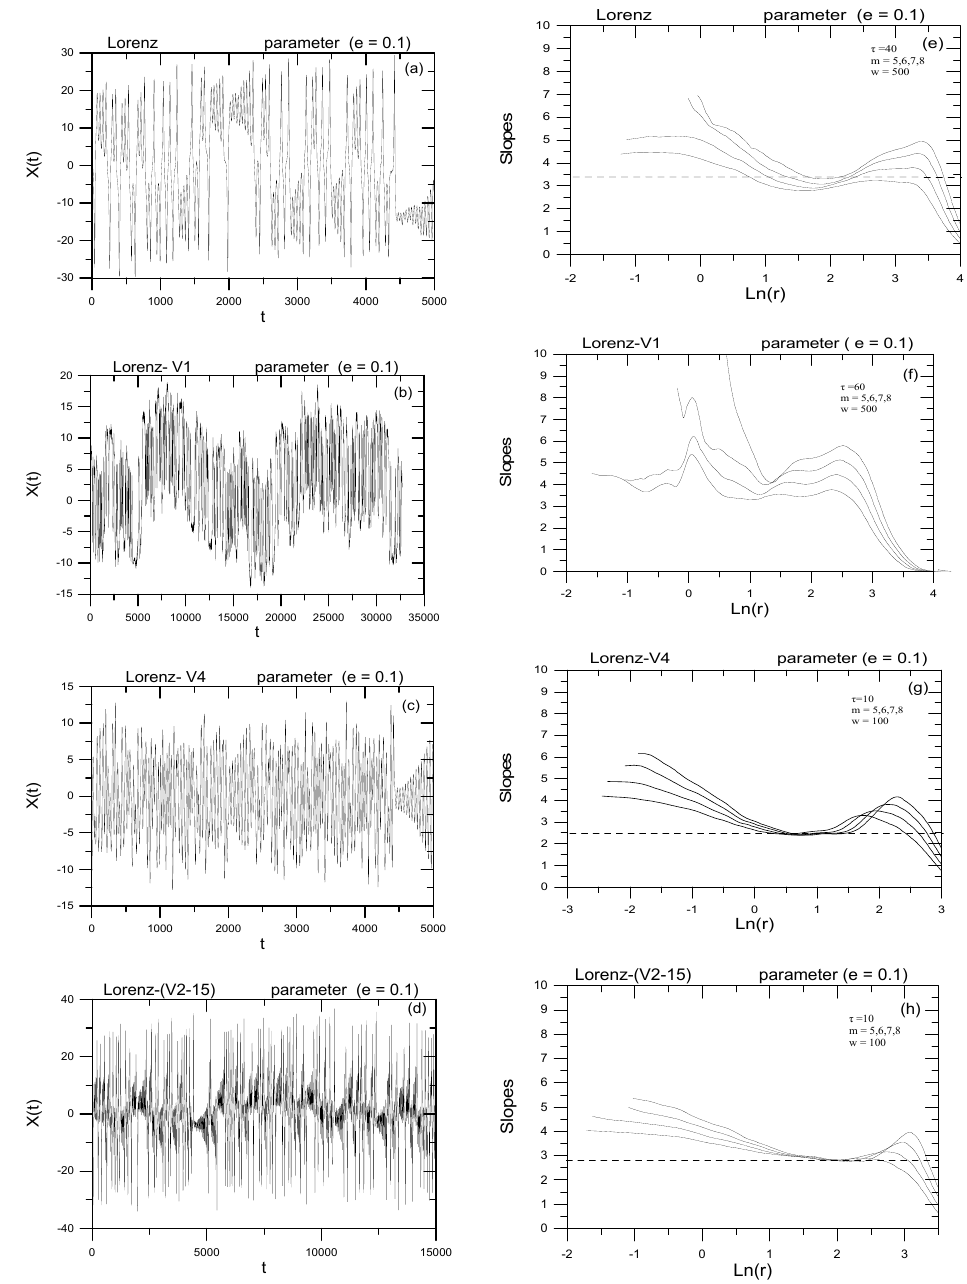
2 Fig. 2. (a)–(d) The stochastic Lorenz signal corresponding to the coloured noise perturbation 37% (e = 0 . 1 ) and its SVD reconstructed components V 1 , V 4 , V 2 − 15 . The last signal V 2 − 15 corresponds to the sum P V i ,i = 2 − 15. (e)–(h) The slopes of the correlation integrals estimated for the signals shown in Fig. 2a–d correspondingly, with embedding m = 5 − 8 and w =